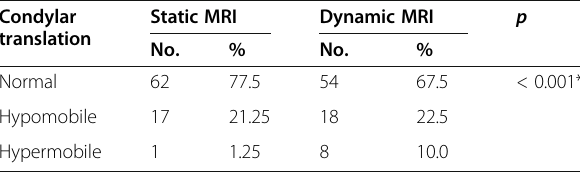
Table 2 Comparison between static and dynamic MRI in evaluation of condylar translation in the examined joints ( n = 80)